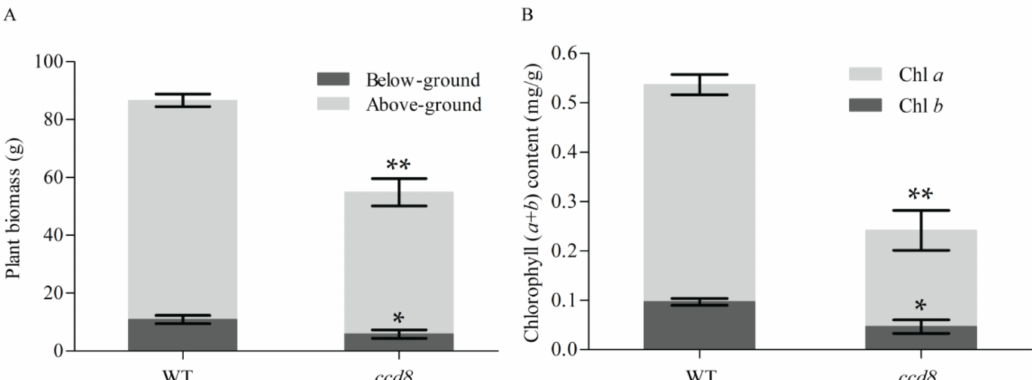
Figure 6. Plant biomass and chlorophyll content in wild-type and ntccd8 mutant plants. ( A ) Dry weight of root and aerial tissue in 50-day-old wild-type and mutant plants. Data are the means ± SD ( n = 3). ( B ) Quantification of total chlorophyll (Chl a and Chl b ) in four-month-old plants leaves ( n = 3 for wild-type and mutant plants). The asterisks indicate statistically significant differences compared to wild-type plants (* p < 0.05 and ** p < 0.01; Student’s t